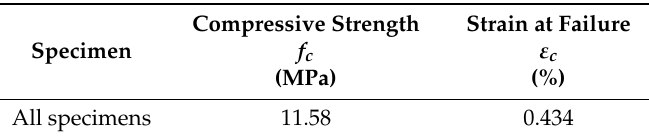
Table 6. Mechanical properties of extruded polystyrene (EPS).